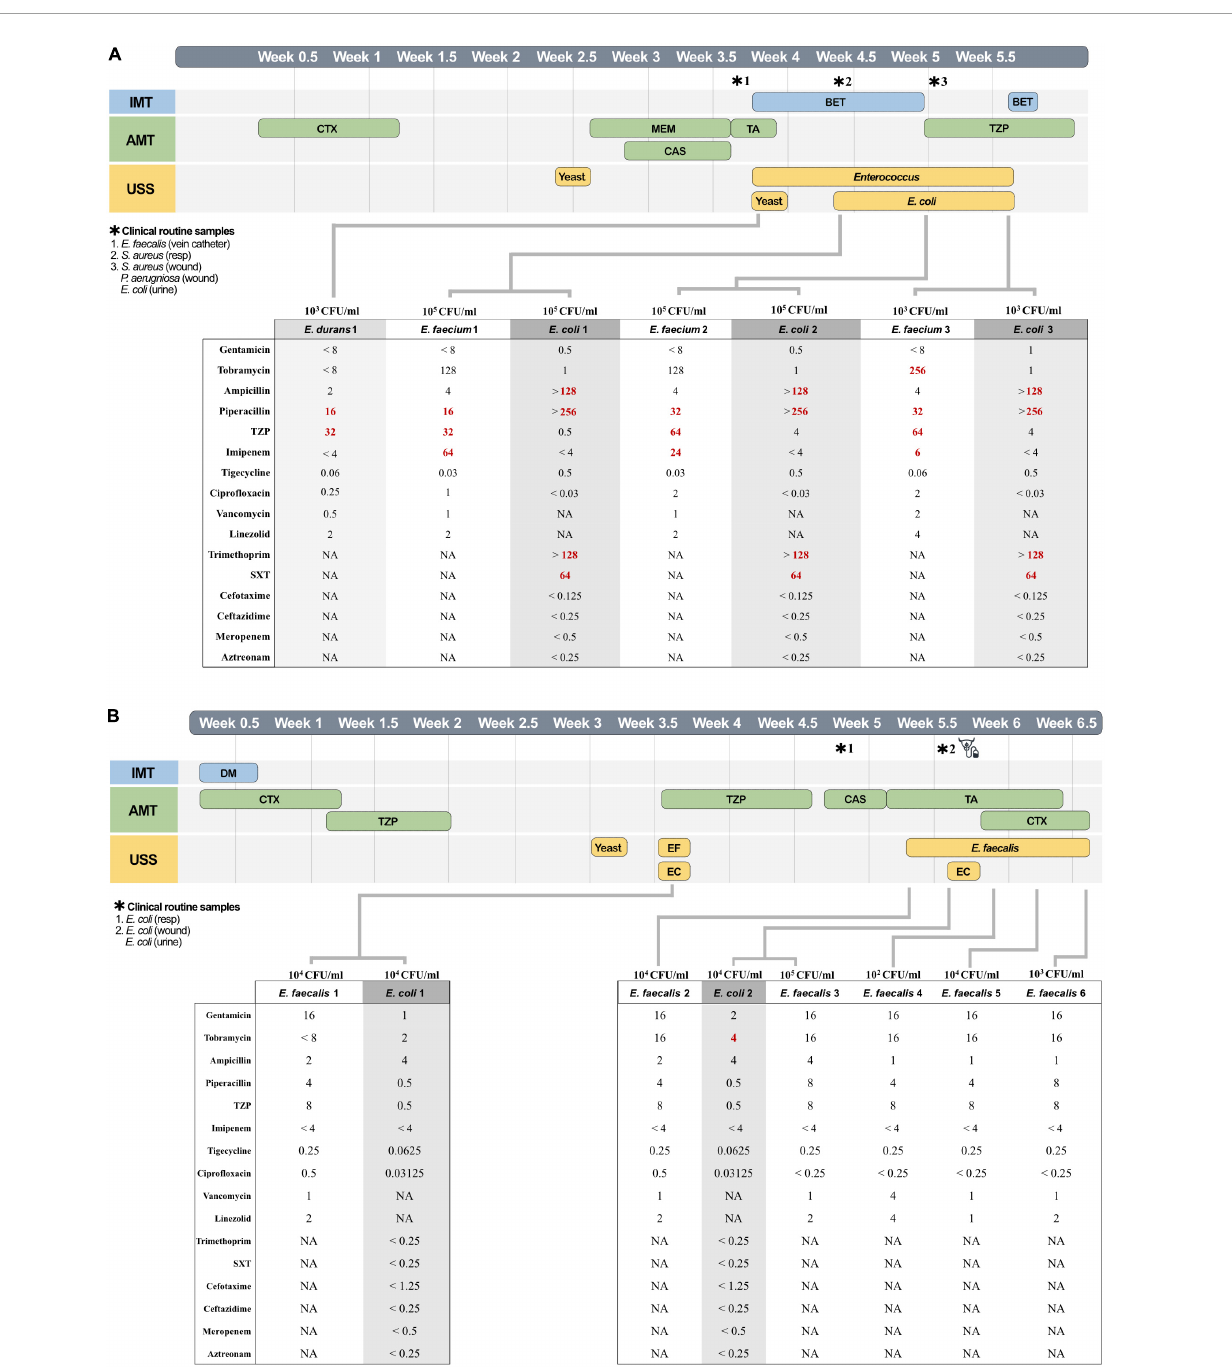
FIGURE6 Individual patient timelines. *Clinical routine samples. Timeline of patient A (A) and patient B (B) at the intensive care unit stays is illustrated in half-weeks. The timeline shows immunomodulatory treatment (IMT, blue), with betamethasone (BET) and dexamethasone (DM), antimicrobial treatment (AMT, green) with caspofungin (CAS), triazole (TA), cefotaxime (CTX), meropenem (MEM), and piperacillin-tazobactam (TZP), and urine study samples (USS, yellow). Stars above the timeline indicate clinical routine samples, and the catheter symbol indicates a change of urinary catheter. The table under the timeline shows the identified minimum inhibitory concentration, with resistance according to The European Committee on Antimicrobial Susceptibility Testing (EUCAST) marked in bold red. In figure (B) E. faecalis and E. coli have been abbreviated EF and EC,